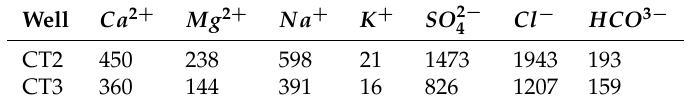
Table 4. Chemical composition (in mg/L) of irrigation water (October 1995) taken from [42].